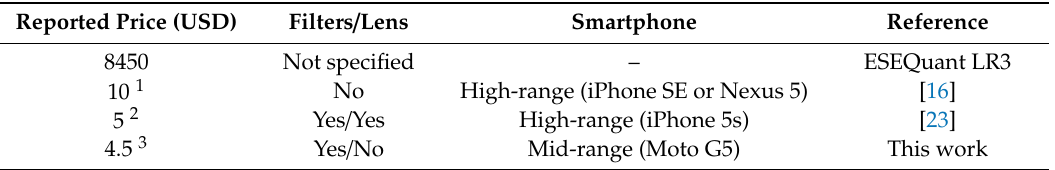
Table 2. Photoluminescence readers for point-of-care applications.